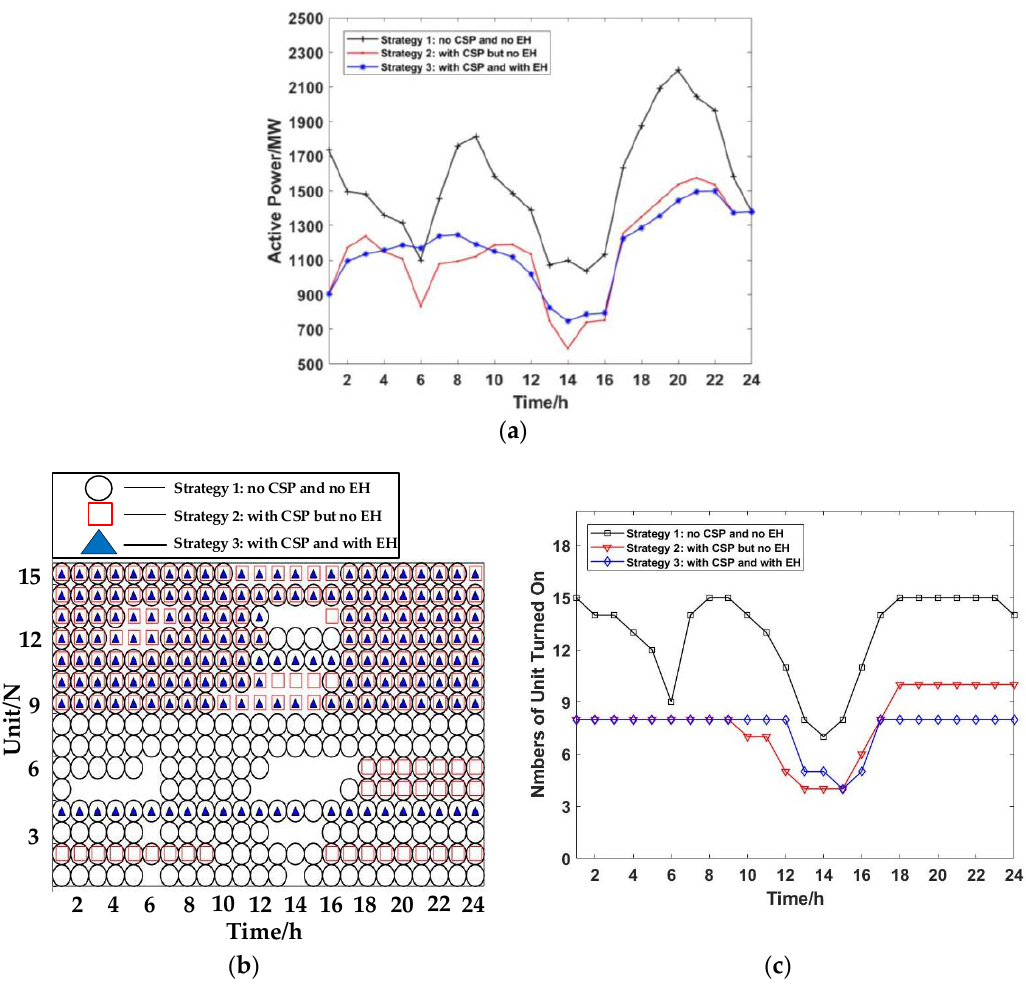
Figure 7. Unit commitment results in three strategies: ( a ) the power supply of traditional thermal units; ( b ) the generation schedule of thermal units; ( c ) the number of thermal units turned on.